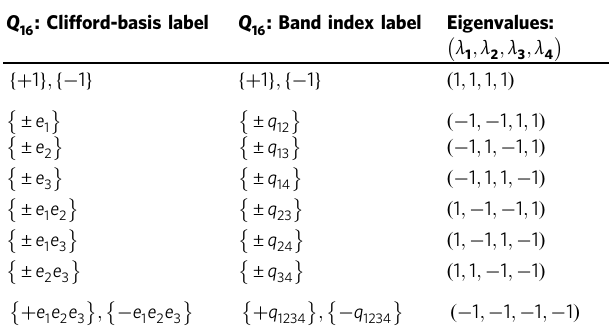
Table 1 Categories of non-Abelian topological charges in four-band